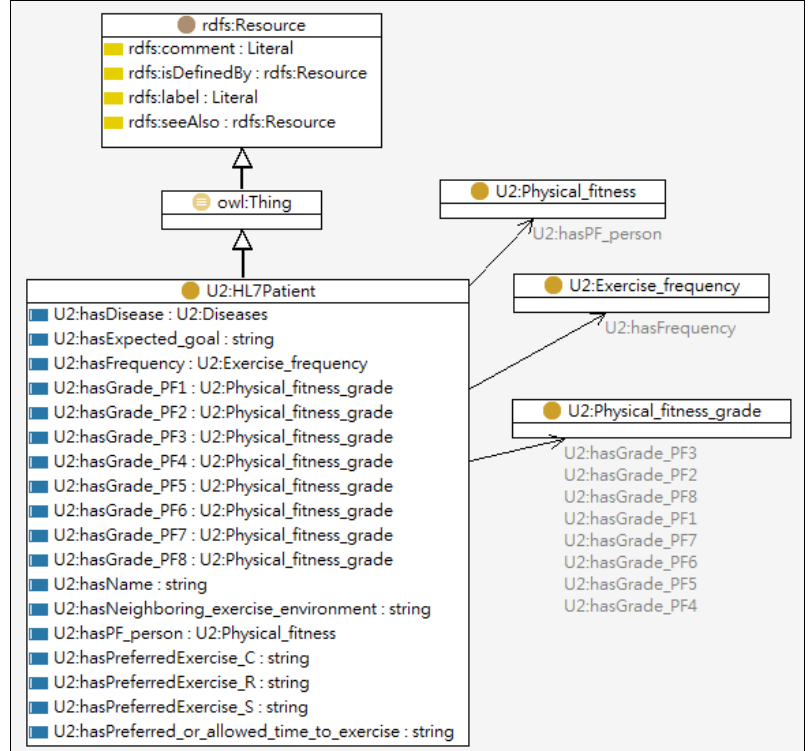
Figure 8. The partial model of user profile